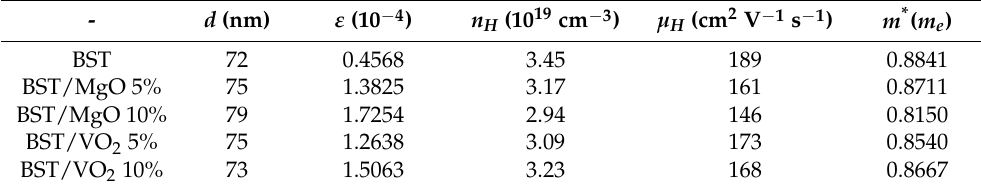
Table 1. The average grain size d , internal lattice strain ε , Hall carrier concentration n H , Hall mobility µ H , and carrier effective mass m ∗ of MgO and VO 2 BST composites.